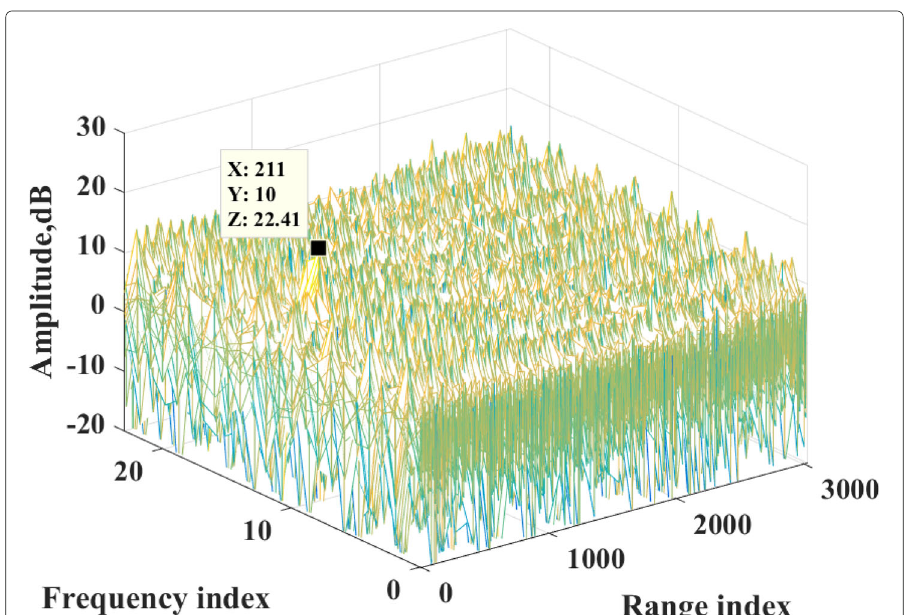
Fig. 10 Coherent integration output of signal processed only by traditional